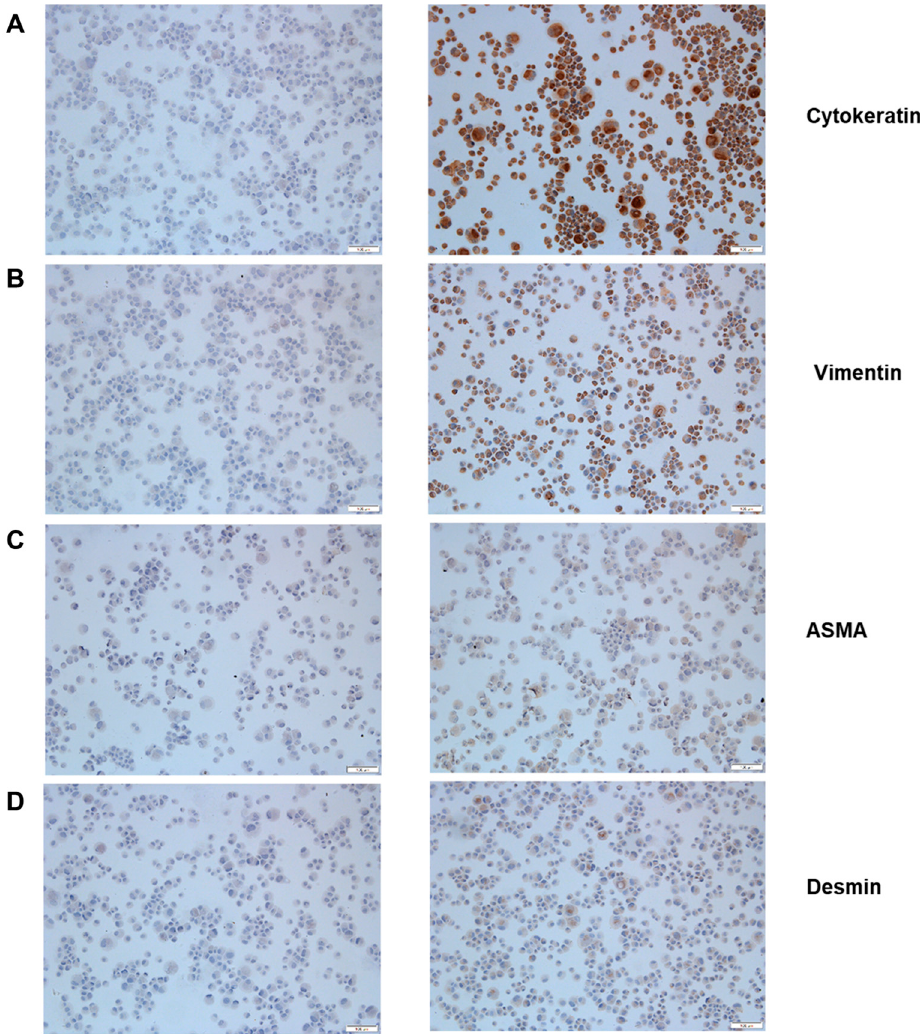
Figure 1. Immunohistochemical staining of MK1-OSU cells for phenotypic markers: cytokeratin, vimentin, α -smooth muscle actin (ASMA), and desmin. Cytospins were prepared and stained with marker-specific monoclonal antibodies. Isotype controls for antibodies were stained concurrently. Cells were stained with cytokeratin ( A ), vimentin ( B ), ASMA ( C ), and desmin ( D ) specific monoclonal antibodies and their isotype controls. The left panel represents the isotype controls for cytokeratin, vimentin, ASMA, and desmin, respectively. As shown in the right panel, cells stained positively for epithelial cell marker, cytokeratin, and fibroblast marker vimentin. The images are representative of three independent experiments. The scale bars on the bottom left corner of each image represents 100 µm length.